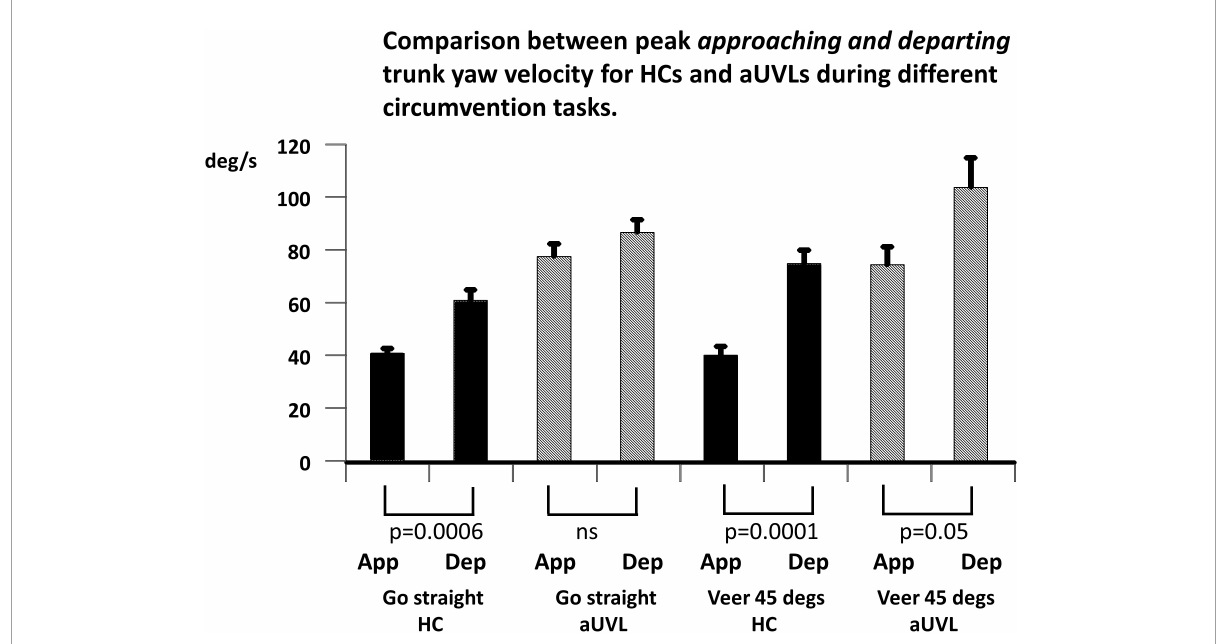
FIGURE7 Comparison between mean peak yaw angular velocities approaching toward and departing from the obstacle peak for patients with aUVL and HCs during different circumvention tasks, as listed below the column plots. The height of the column represents the mean population value, and the vertical bar, the SEM. The pair-wise levels of significant differences are indicated below the columns. Note that the HCs show the most significant